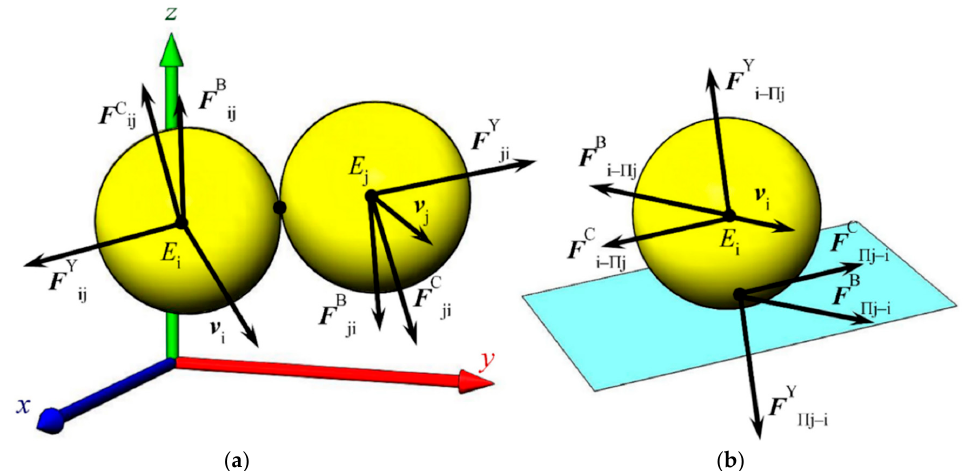
Figure 13. Schemes of force contact of elements: ( a )—forces arising from the contact of two discrete elements; ( b )—forces arising from the contact of the discrete element and a solid surface; F Y —elastic forces; F C and F B —dry and viscous friction forces.